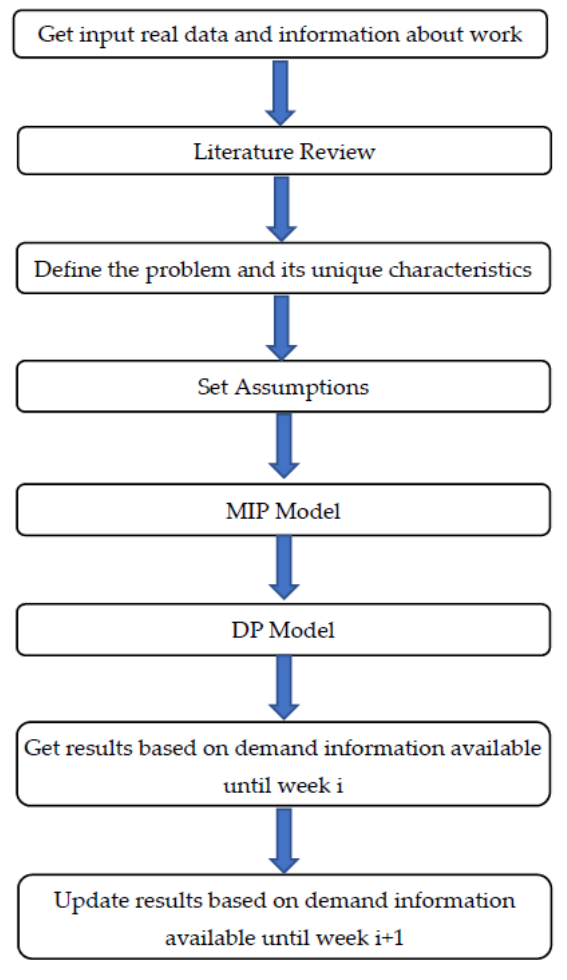
Figure 1. Study general steps.